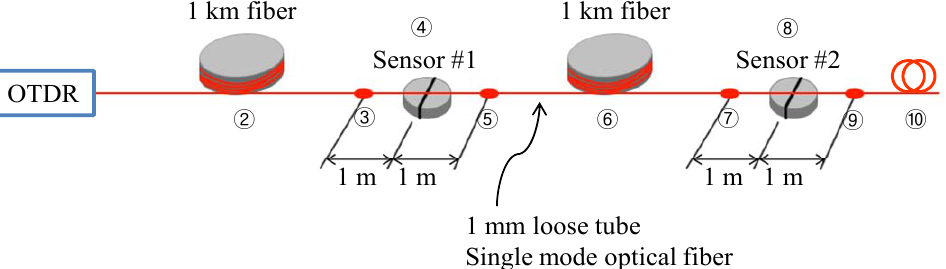
Figure 4. Experimental setup of MOL-FOS for water leak detection.